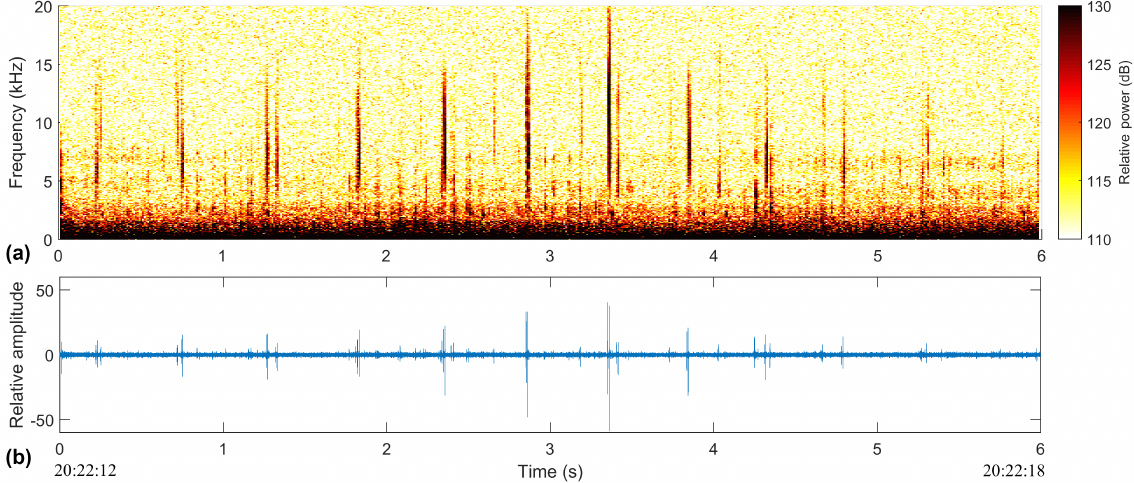
Figure 5. Example of possible sperm whale multipath arrivals – here evidenced by fainter clicks following the stronger first arrivals, more noticeable between 2 and 5s and shown on both spectrogram (a) and waveform (b) of 6s of data from channel 1.